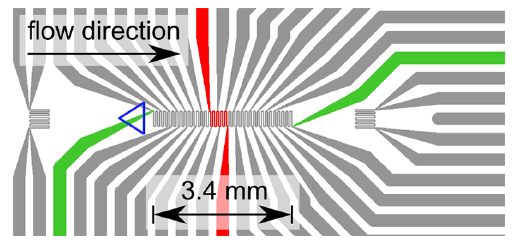
Figure 4. Enlarged view of the developed sensor layout with trian- gular bluff body (Schmitt et al.,